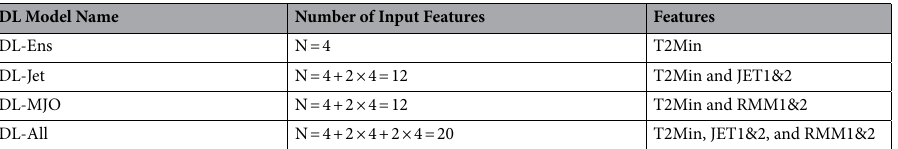
Table 1. Four DL models with different numbers of features (N) for the input layer. For the BCC model, each of T2Min, RMM1, RMM2, JET1, and JET2 at a grid cell has the predictions of four ensemble